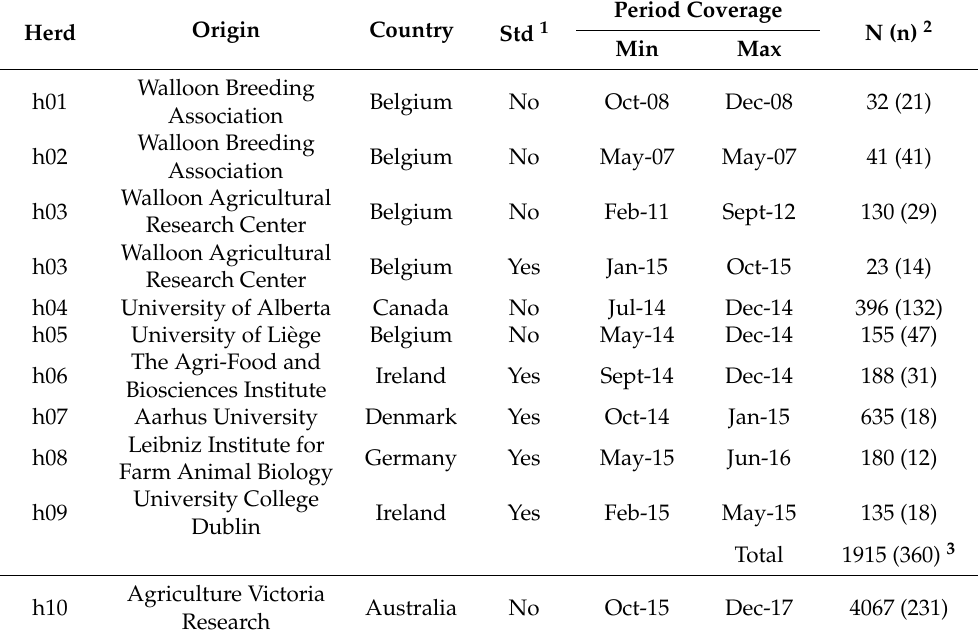
Table 1. Sampling information for each studied herd included in the